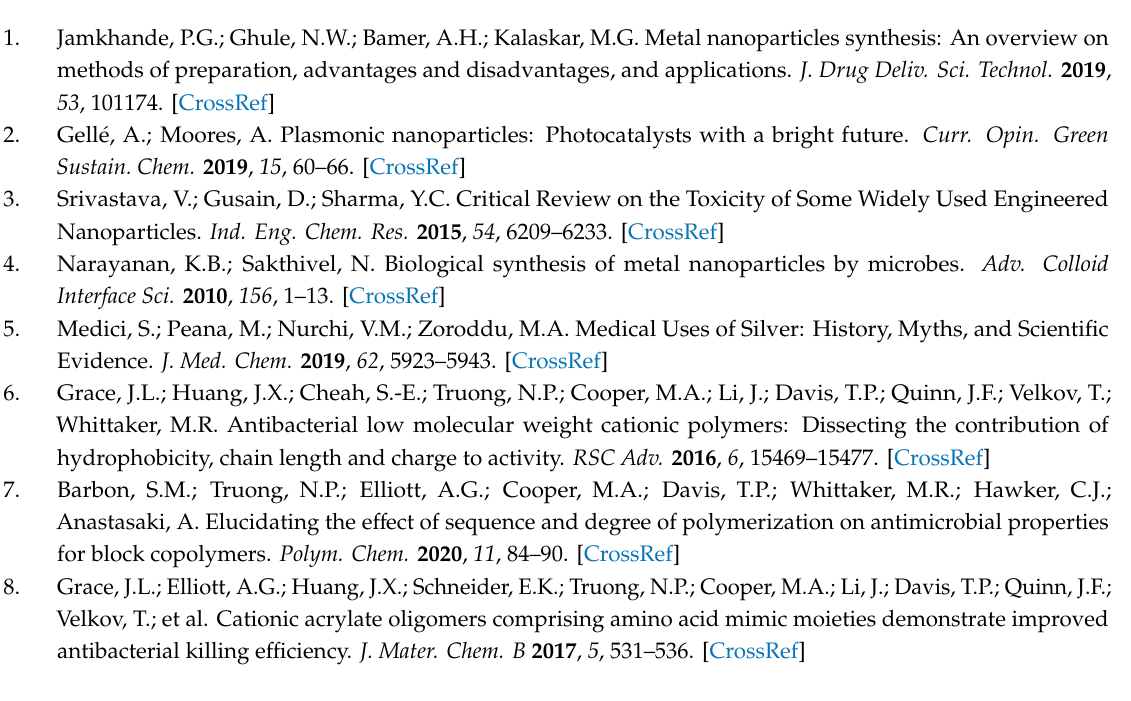
Figure S1: The zeta potential of P.uri.AgNP (a), P.zey.AgNP (b) and S.dul.AgNP (c); Figure S2: The SEM images of P.uri.AgNP (a), P.zey.AgNP (b) and S.dul.AgNP (c); Table S1: The summary of phytoconstituents in P. urinaria, P. zeylanica , and S. dulcis